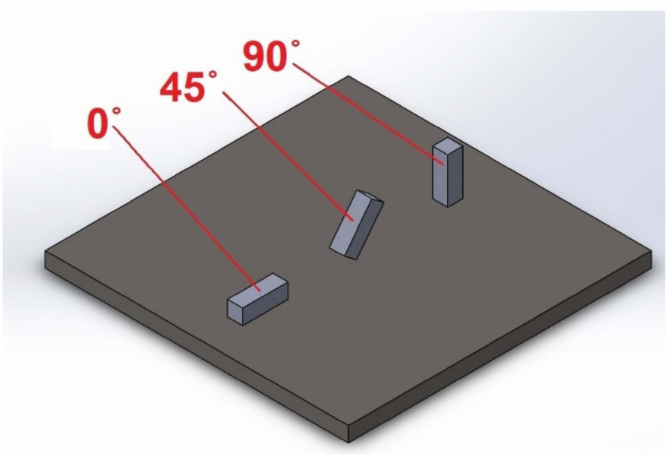
Figure 1. Location of the samples on the 3D printing